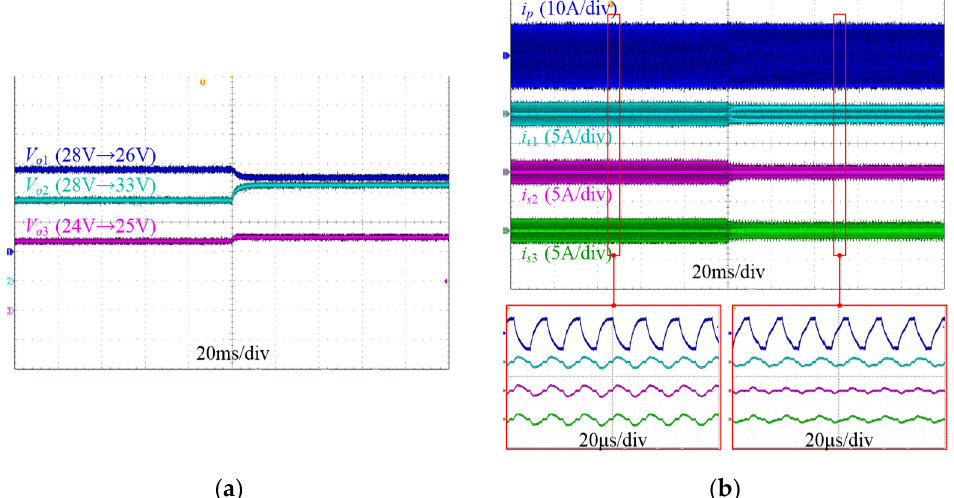
Figure 14. Experimental waveforms of load change from balance to unbalance conditions. ( a ) Wave- forms of the output voltages. ( b ) Waveforms of the current transformers.